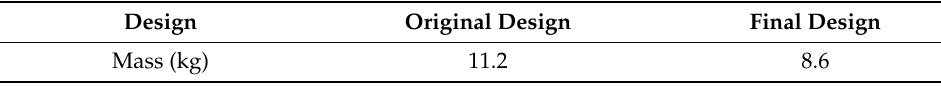
Table 2. Comparison of original and optimized designs.